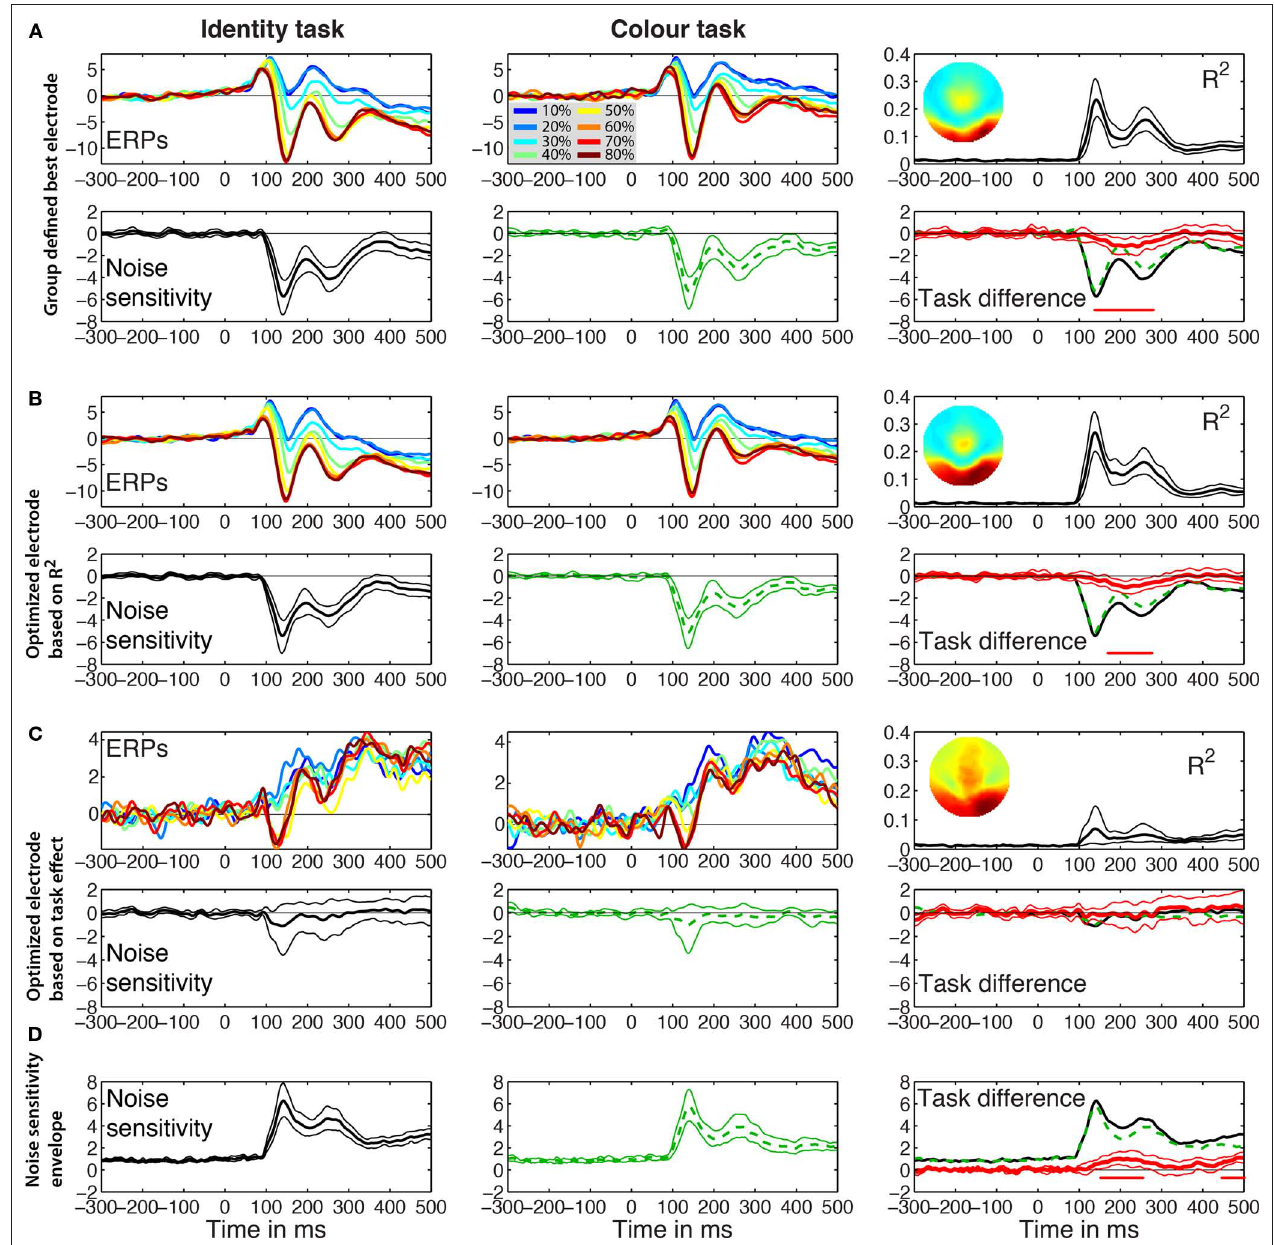
difference observed within the first 300 ms after stimulus onset, noise sensitivity in the identity task was − 4 μV/std, color = − 2.8 μV/std, difference = − 1.2 μV/std. (B) R 2 optimized electrode. The topographic map was obtained by averaging the maps from individual subjects. At the latency of the maximum task difference, noise sensitivity in the identity task was − 2.8 μV/std, color = − 1.8 μV/std, difference = − 1 μV/std. (C) Task effect optimized electrode. The R 2 bump between 100 and 200 ms was mostly due to three subjects (S9–S11) who had maximum task effects at electrodes that were part of the cluster of electrodes with the maximum R 2 . (D) Noise sensitivity envelope. The maximum across electrodes of the absolute noise sensitivity was used for each subject. At the latency of the maximum task difference, noise sensitivity in the identity task was 3.9 μV/std, color = 2.8 μV/ std, difference =